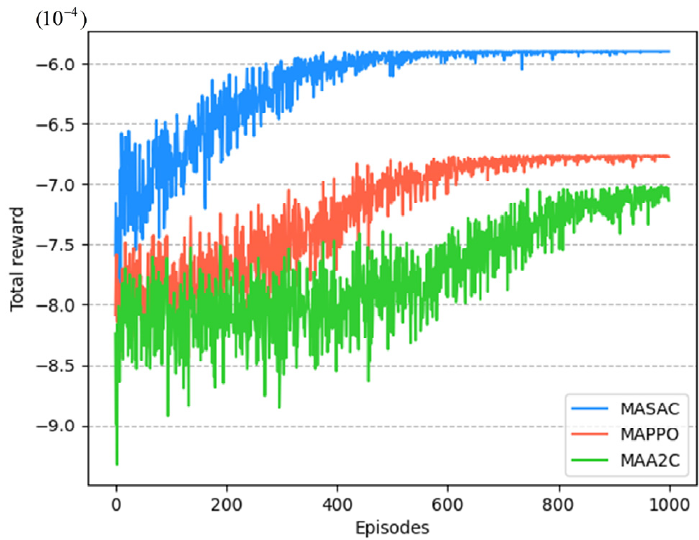
Figure 14. Comparison of different RL algorithm’s total reward.